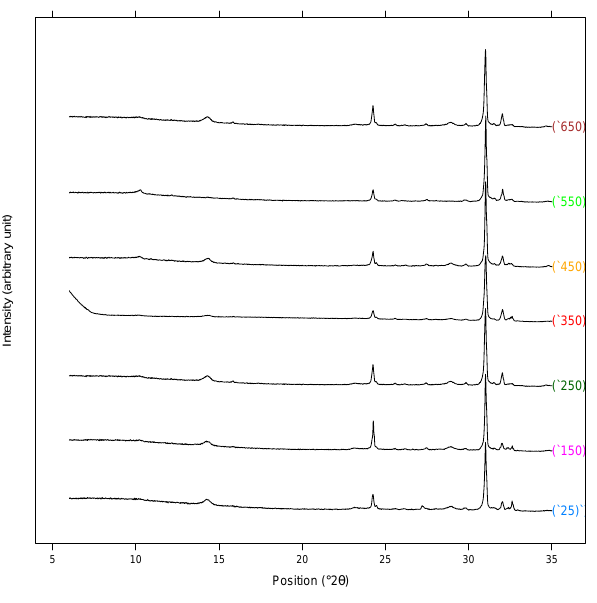
Figure 6. XRD diagram for Music series